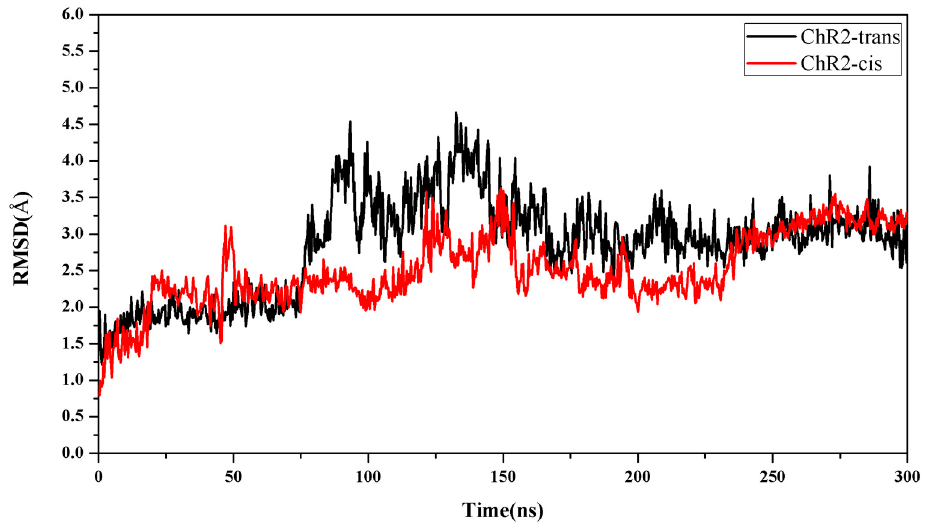
Figure 3. Time evolutions of root mean square difference (RMSD) of backbone atoms of ChR2-trans (black) and ChR2-cis (red).